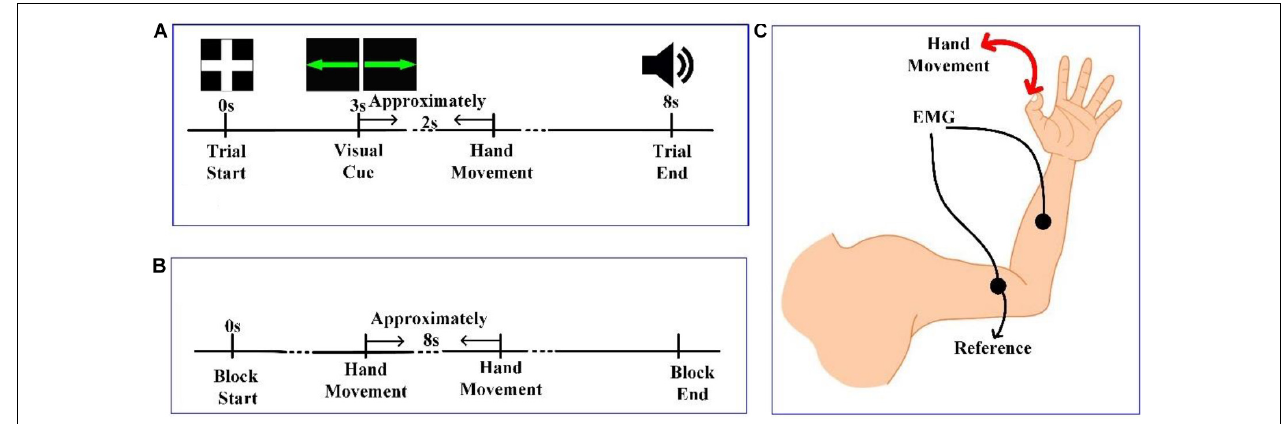
FIGURE 1 | (A) The timeline of a trial in experiment 1. (B) The timeline of a session in experiment 2. (C) Diagram of hand movement and positioning of electromyographic (EMG) electrodes.